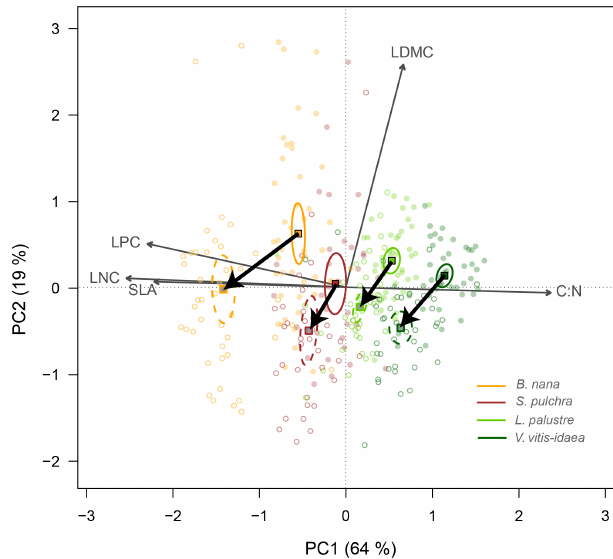
Figure 2. Principal component biplot of leaf traits for all four shrub species combined, showing change along the leaf conservative– acquisitive continuum (thick black arrows) when nutrients were added. Leaf traits included are leaf dry matter content (LDMC), carbon-to-nitrogen ratio (C : N), leaf nitrogen content (LNC), leaf phosphorus content (LPC) and specific leaf area (SLA). Points are the trait scores of individuals without fertilization (closed circles) and with fertilization (open circles). Sample scores are scaled by a factor of 15, and variable loadings by a factor of 7. Squares indicate the centre of the ordiellipses (standard error with 95% confidence interval) of trait scores without nutrient addition (solid lines) and with nutrient addition (dashed lines). The first principal component explains 64% of the total variance, while the second component explains